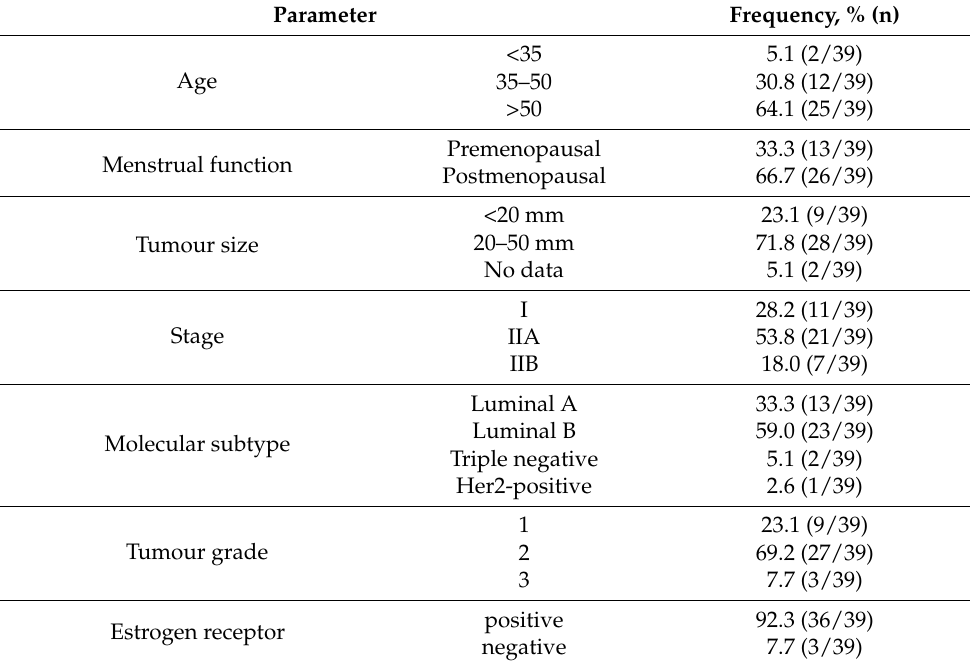
Table 5. The number of 24 studied CTC phenotypes in groups of patients with and without lym- phogenous